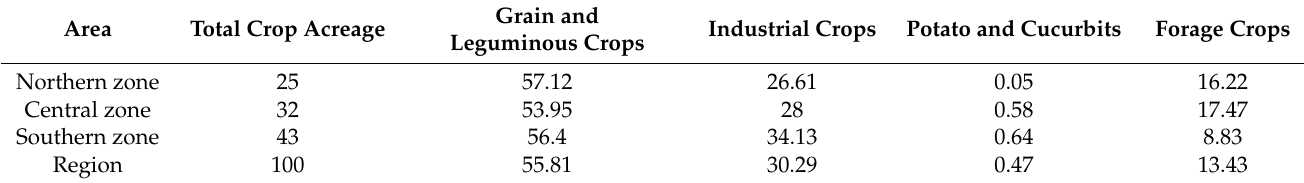
Table 3. Structure of crop acreage by agricultural zones of the Samara region